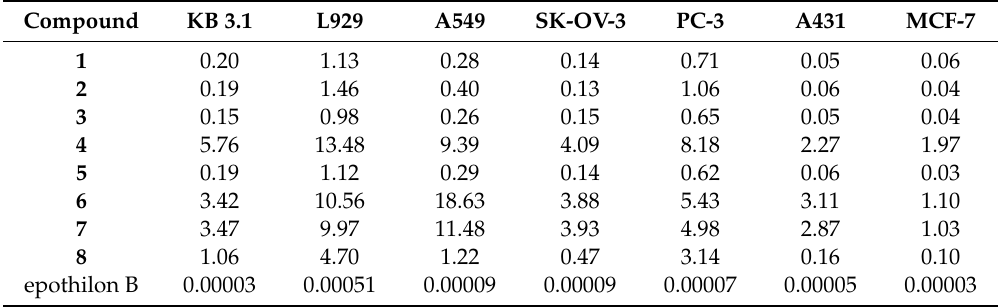
Table 4. Cytotoxicity of 1 – 8 against mammalian cell lines [half maximal inhibitory concentrations (IC 50 ): µ